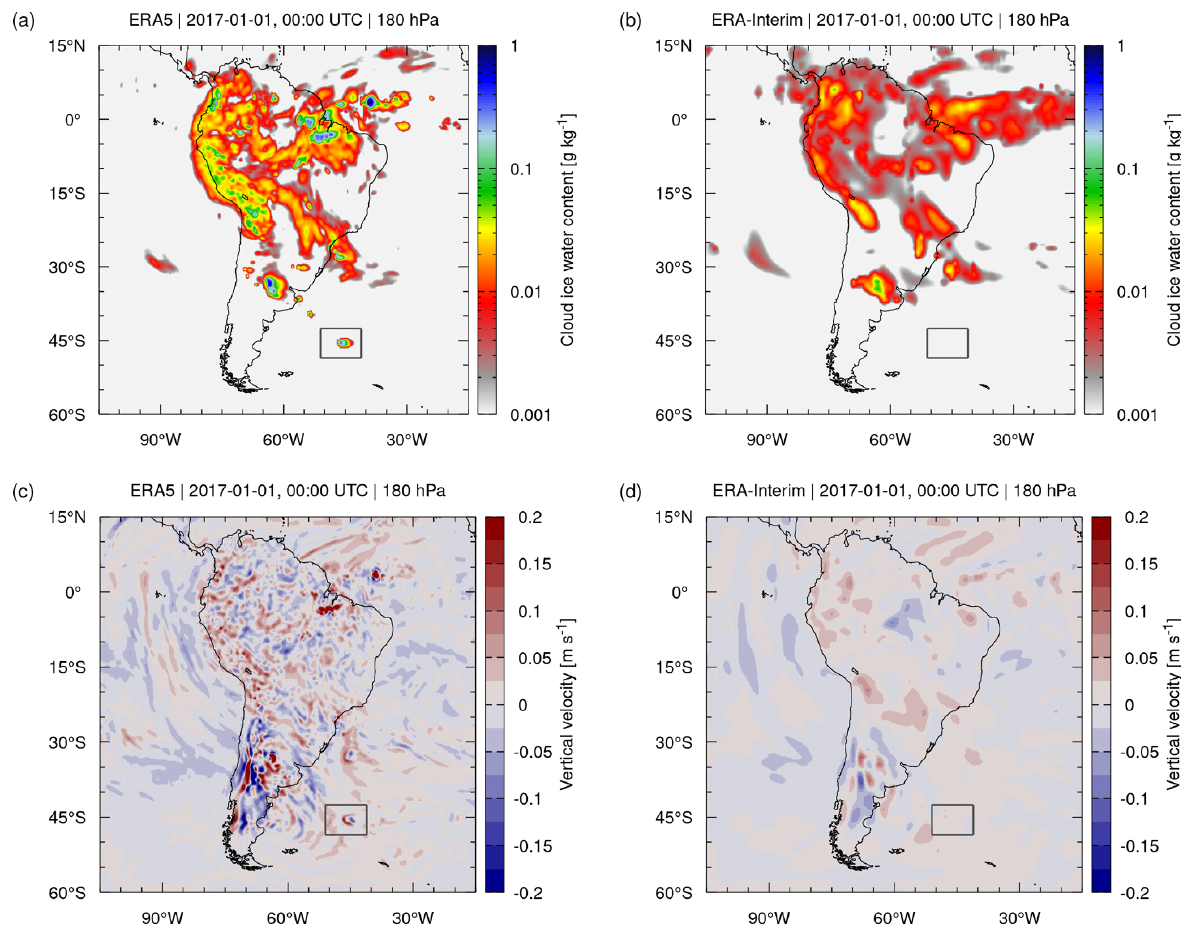
Figure 12. Ice water content (a, b) and vertical velocities (c, d) of ERA5 (a, c) and ERA-Interim (b, d) on 1 January 2017, 00:00UTC, at the 180hPa pressure level. The gray box near (45 ◦ S, 45 ◦ W) highlights a convective event in the ERA5 data (see text for